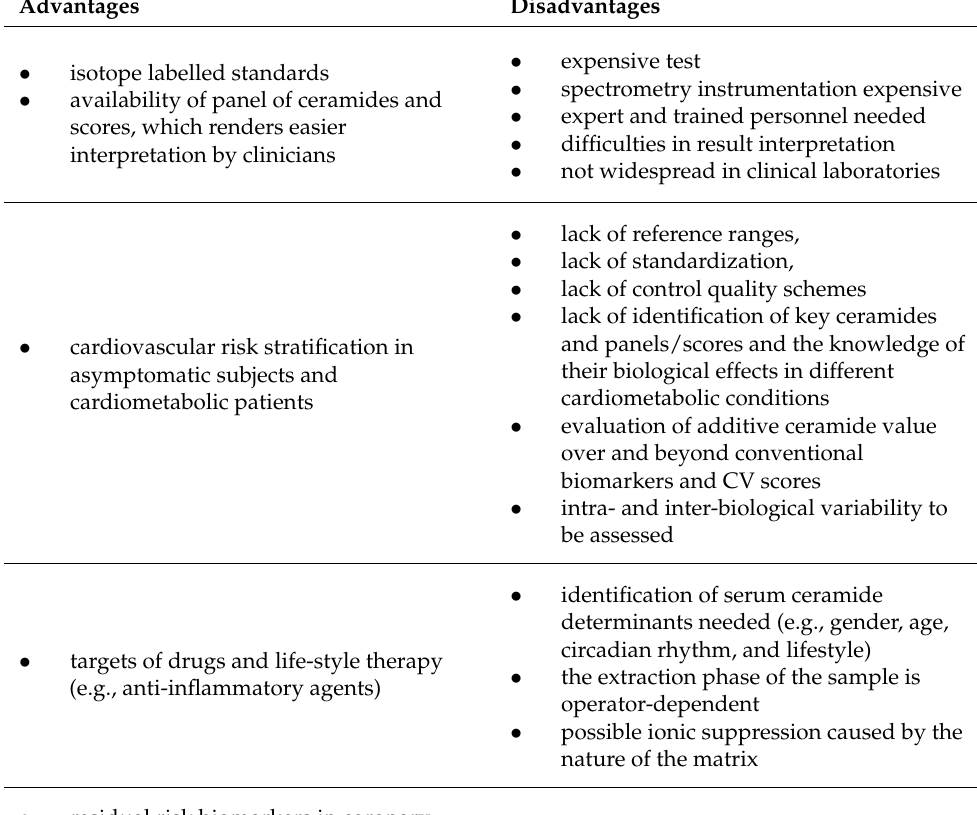
Table 4. Main ceramide advantages and disadvantages for Translational and Clinical